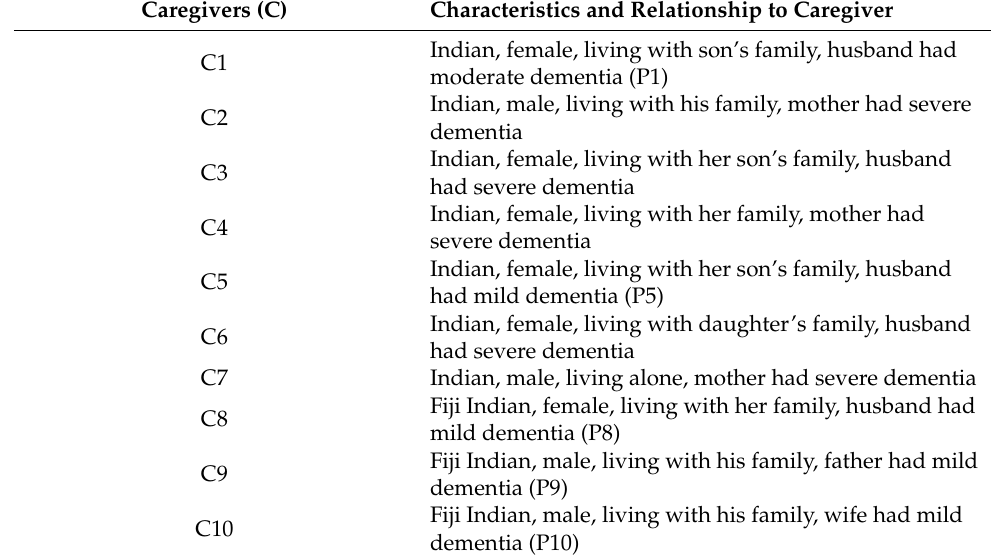
Table 2. Characteristics of the 10 caregiver participants and their relationship to the person living with